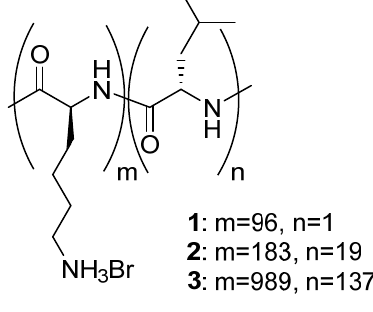
Figure 1. Chemical structures of the diblock copolypeptide amphiphiles K L ( 2 ) and K K 183 19